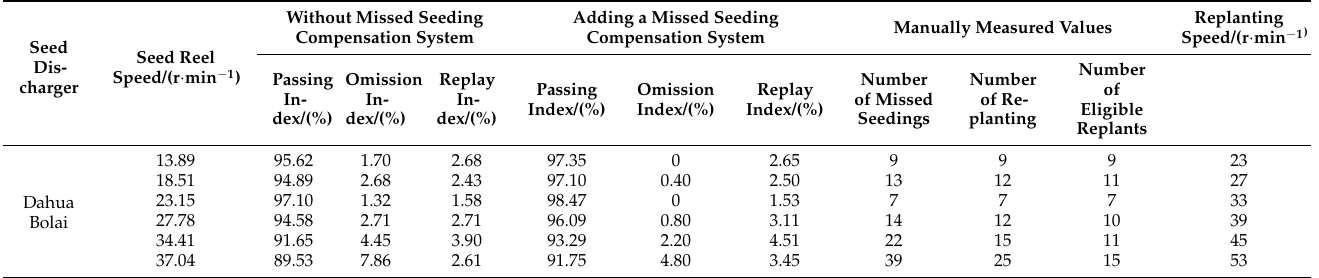
Table 5. The result of loss sowing detection and reseeding system of precision sowing for corn bench